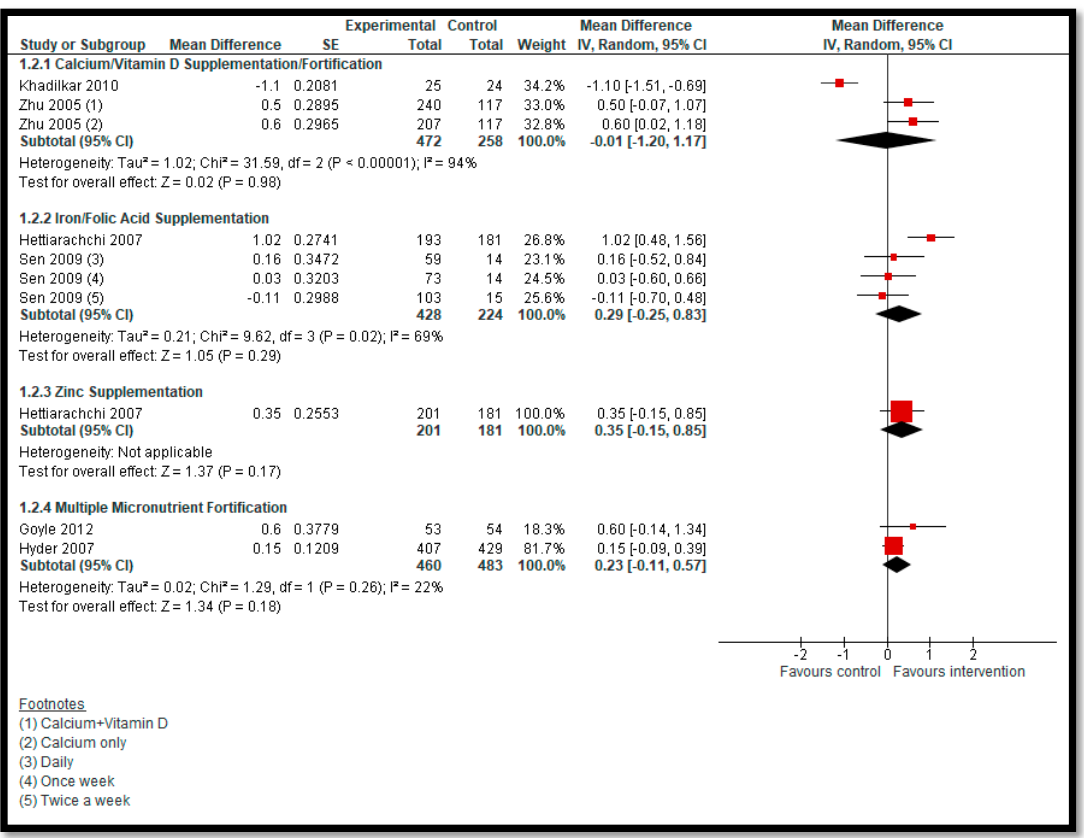
Figure 4. Impact of micronutrient supplementation / fortification on body mass index (BMI).